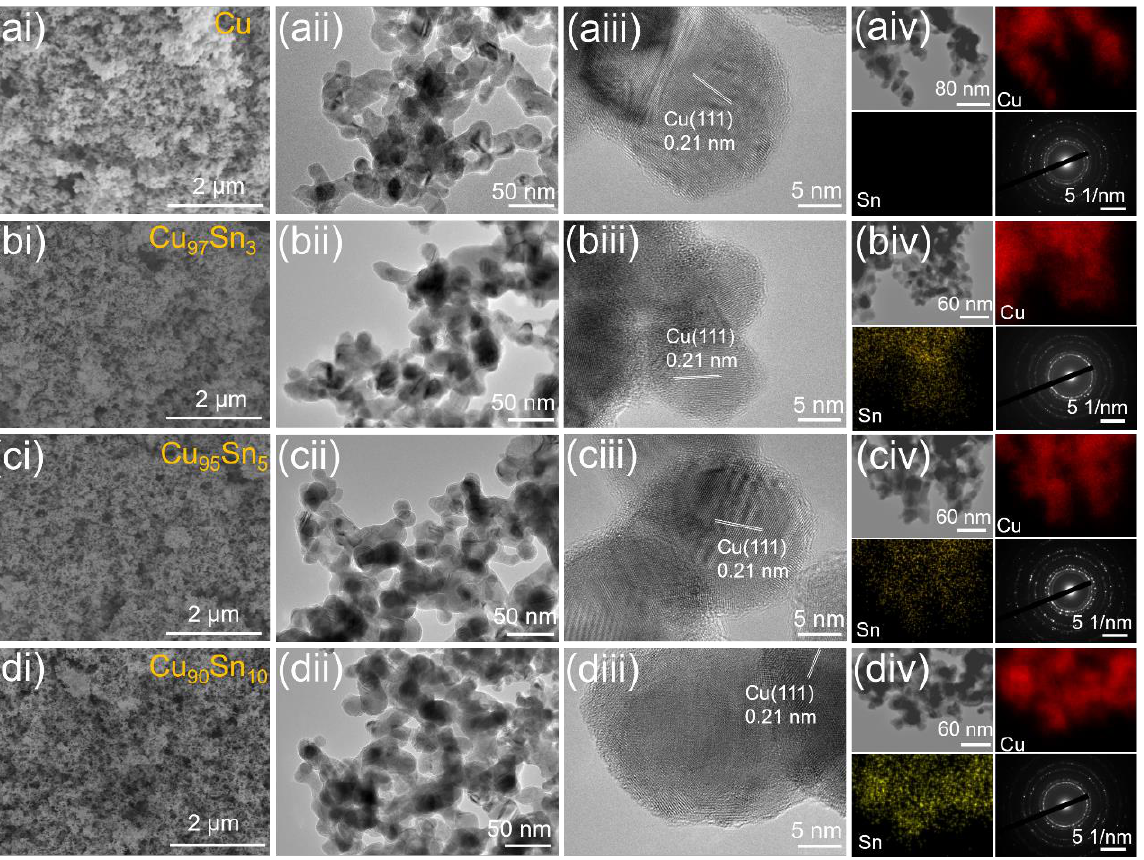
Figure 2. SEM, TEM, HRTEM, EDX mapping images and SAED patterns of Cu ( ai – aiv ), Cu 97 Sn 3 ( bi – biv ), Cu 95 Sn 5 ( ci – civ ), and Cu 90 Sn 10 ( di – div ) aerogels. ( bi – biv ), Cu 95 Sn 5 ( ci – civ ), and Cu 90 Sn 10 ( di – div )